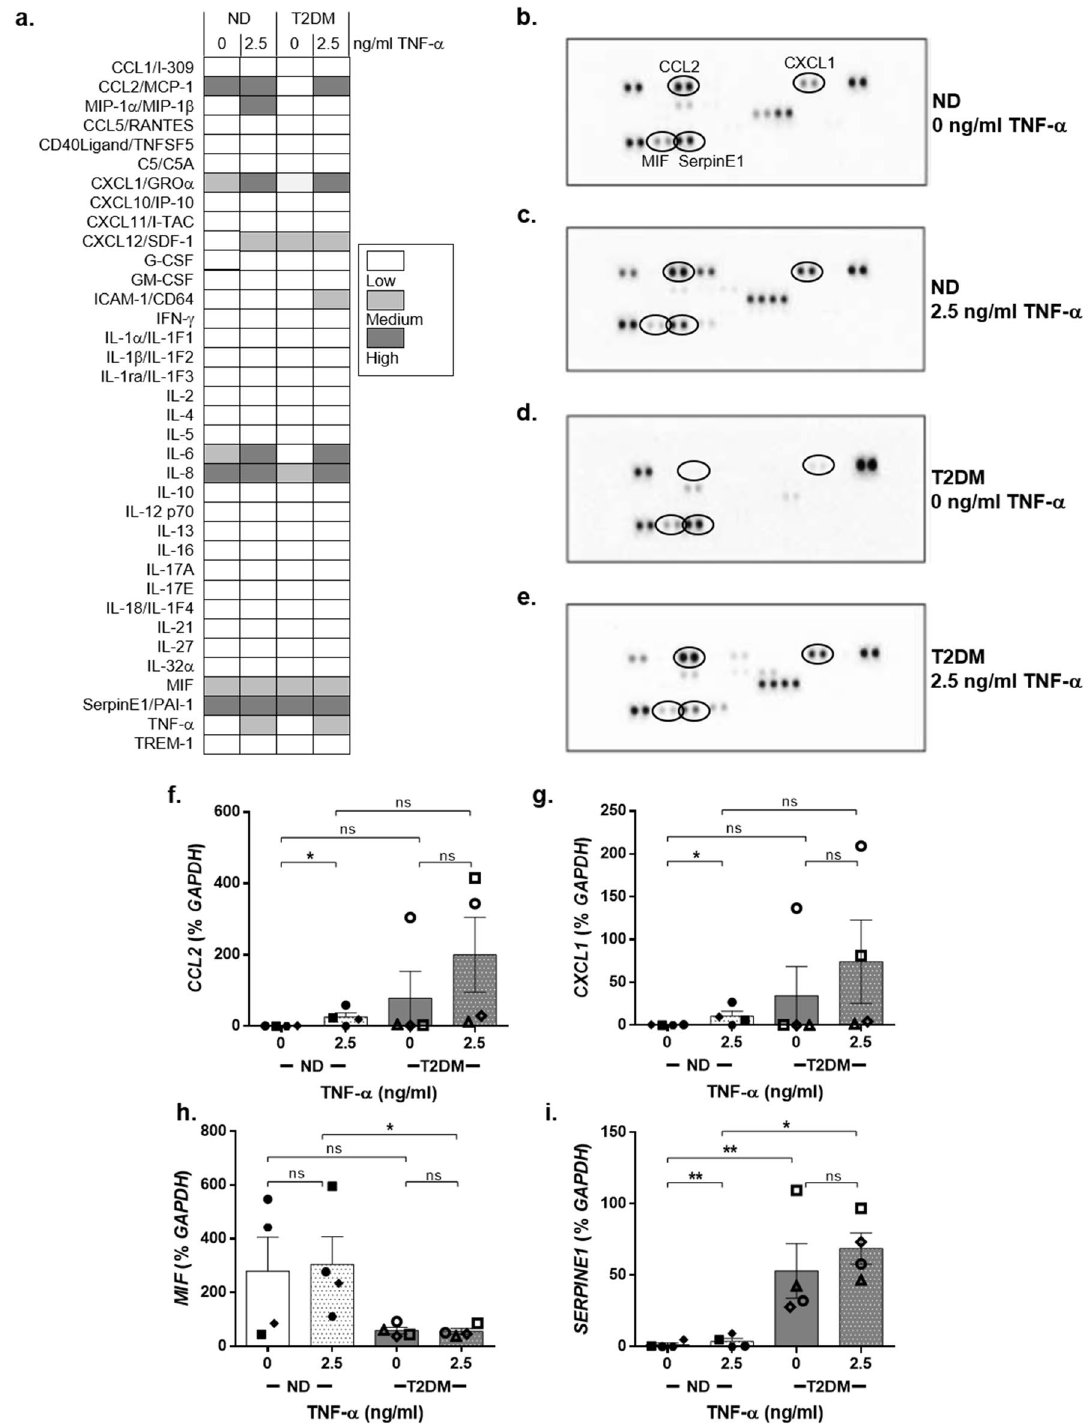
Figure 5. Cytokine secretion in ND-DF and T2DM-DF. The secretion of multiple cytokines was measured in conditioned media from the migration assays using R&D Systems Human Cytokine Array Panel A. ( a ) Heatmap of the cytokines contained within the array and expression in ND and T2DM-DF, both basally and in response to 2.5 ng/ml TNF-α. ( b ) Representative dot blot used in the heatmap analysis for ND-DF under control (basal conditions), ( c ) ND-DF in response to TNF-α, ( d ) T2DM-DF under control (basal conditions) and ( e ) T2DM-DF in response to TNF-α. ( f ) Gene expression of CCL2 , (g) CXCL1 , ( h ) MIF and ( i ) SERPINE1 was measured in the cells from the migration assays (both n = 4 donors). Two-way ANOVA with Sidak post-hoc test, ** P < 0.01, * P < 0.05, ns =